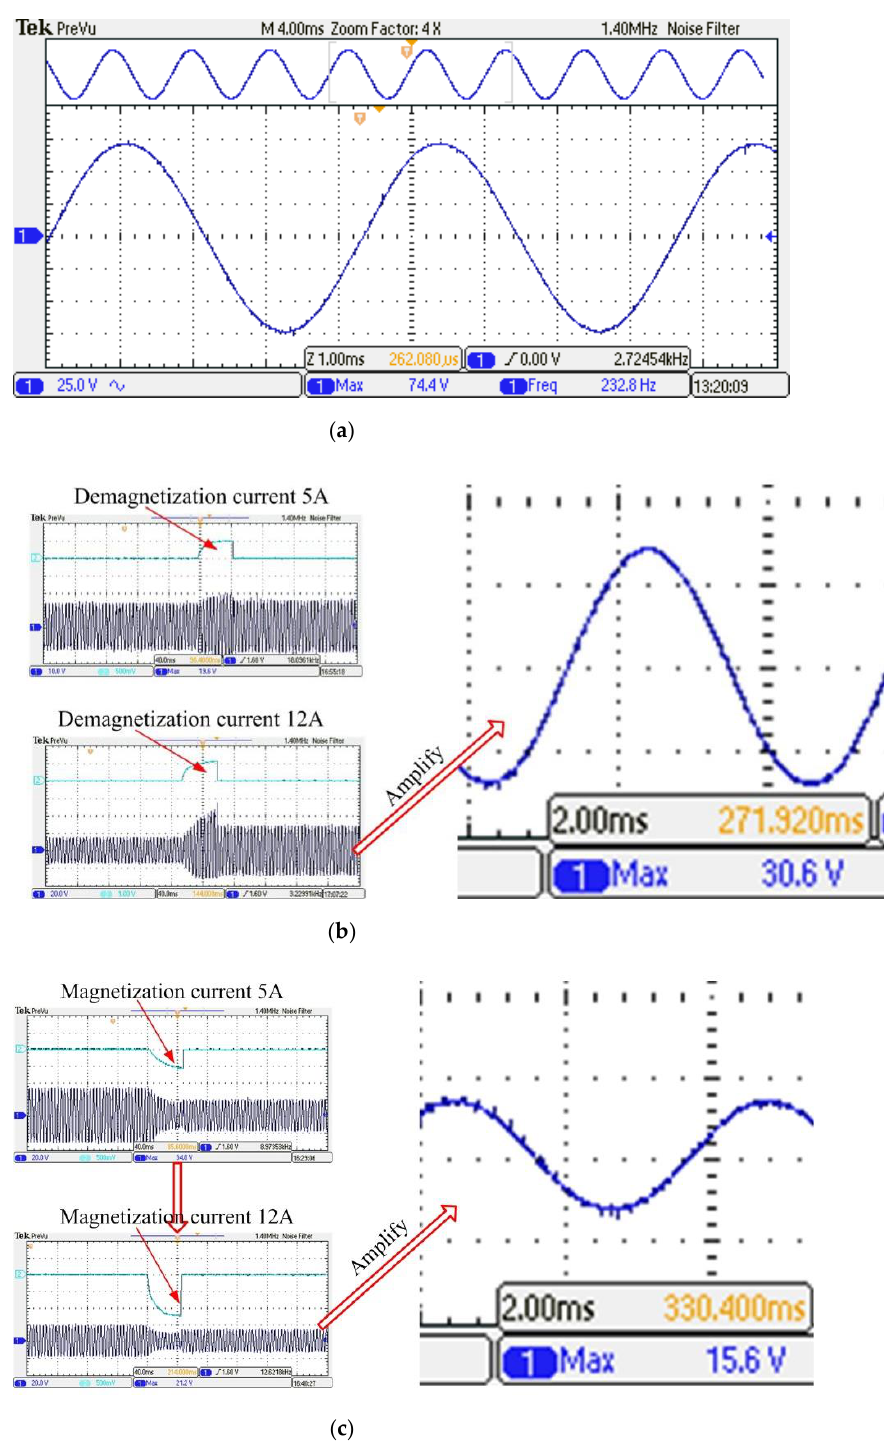
Figure 10. Back EMF waveforms of FSPM machine and VFMPM machine. ( a ) Back EMF waveform of FSPM machine; ( b ) Back EMF waveform of VFMPM machine after enhance flux; ( c ) Back EMF waveform of VFMPM machine after weaken flux.